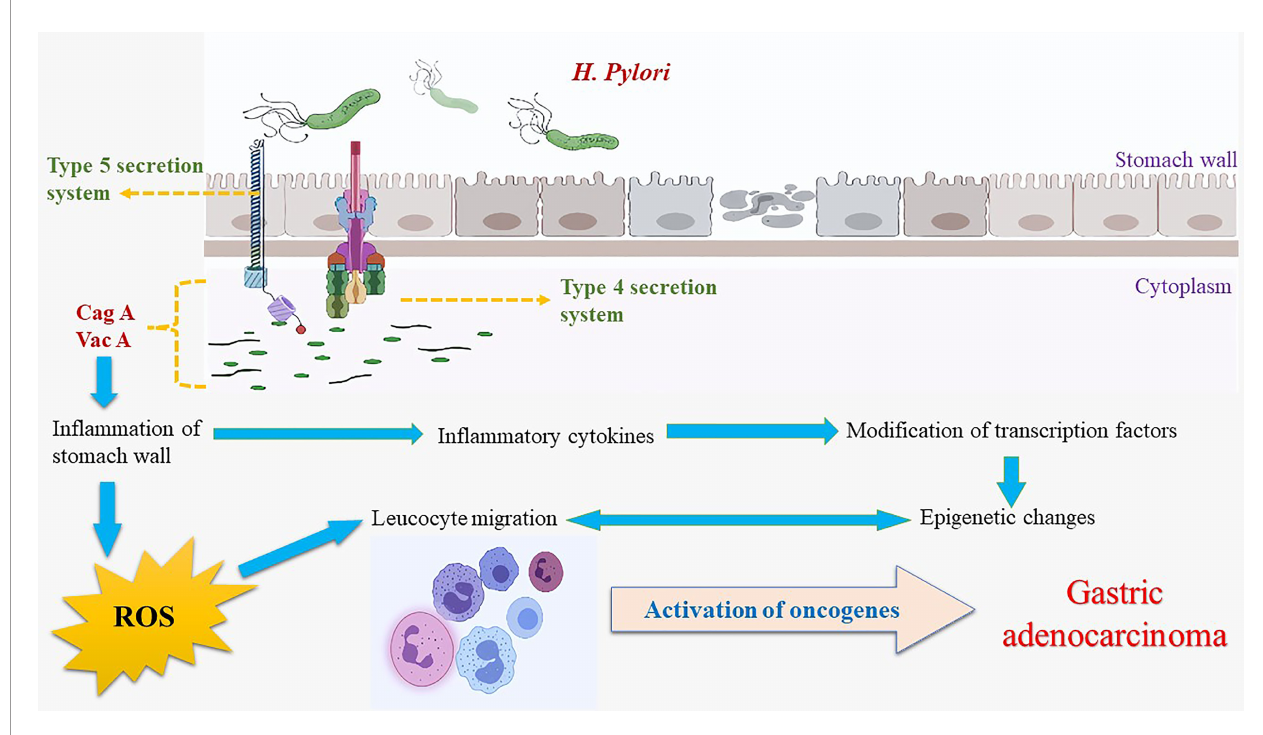
FIGURE 2 | Etiopathogenesis of gastric adenocarcinoma with H. pylori